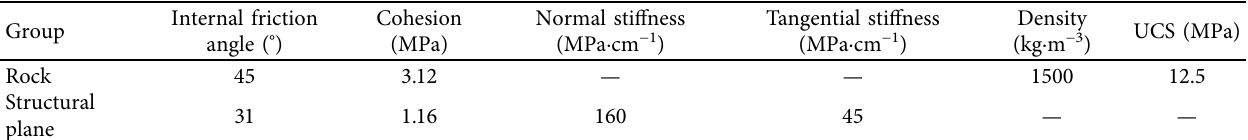
Figure 3: Models and their interfaces. (a) No structural plane. (b) Horizontal model. (c) Model with 15 ° . (d) Model with 30 ° . (e) Model with 45 ° . (f) Model with 60 ° . (g) Model with 90 ° . (h) Horizontal structural plane. (i) Structural plane with 15 ° . (j) Structural plane with 30 ° . (k) Structural plane with 45 ° . (l) Structural plane with 90 ° . Table 1: Mechanical parameter of